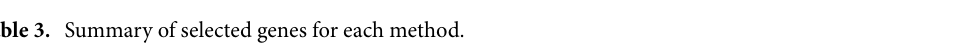
Table 3. Summary of selected genes for each